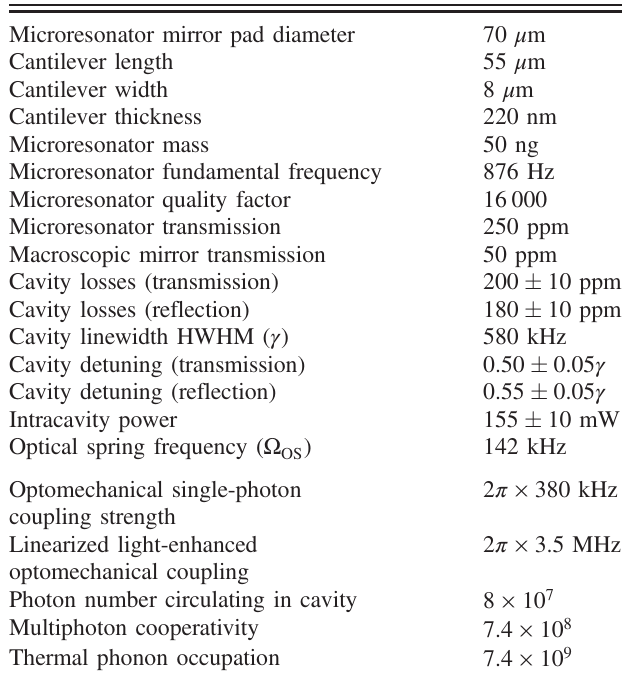
TABLE I. Properties of the microresonator and experimental parameters determined from measurements. The second half of the table has the common optomechanical parameters for comparison with the current state-of-the-art optomechanical systems. As explained in the Methods section of Ref. [12], these parameters are used to characterize an on-resonance system and are not used in our calculations.